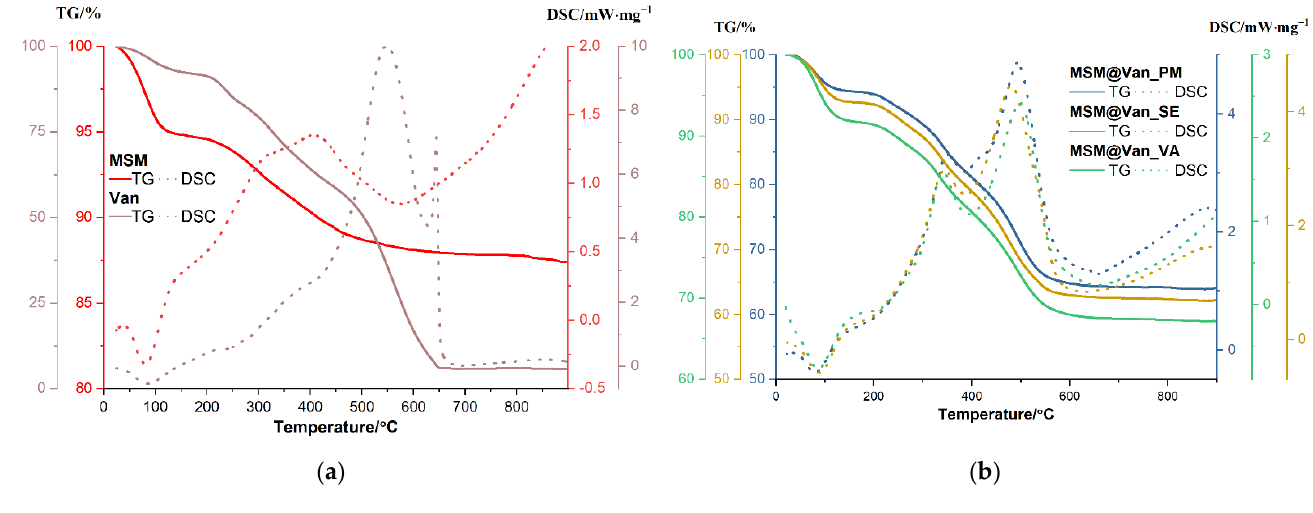
Figure 5. TGA curves and DSC profiles of ( a ) bare mesoporous silica material and vancomycin; ( b ) loaded mesoporous silica materials using the three different loading methods. Table 3. MSM characteristics from TGA values.